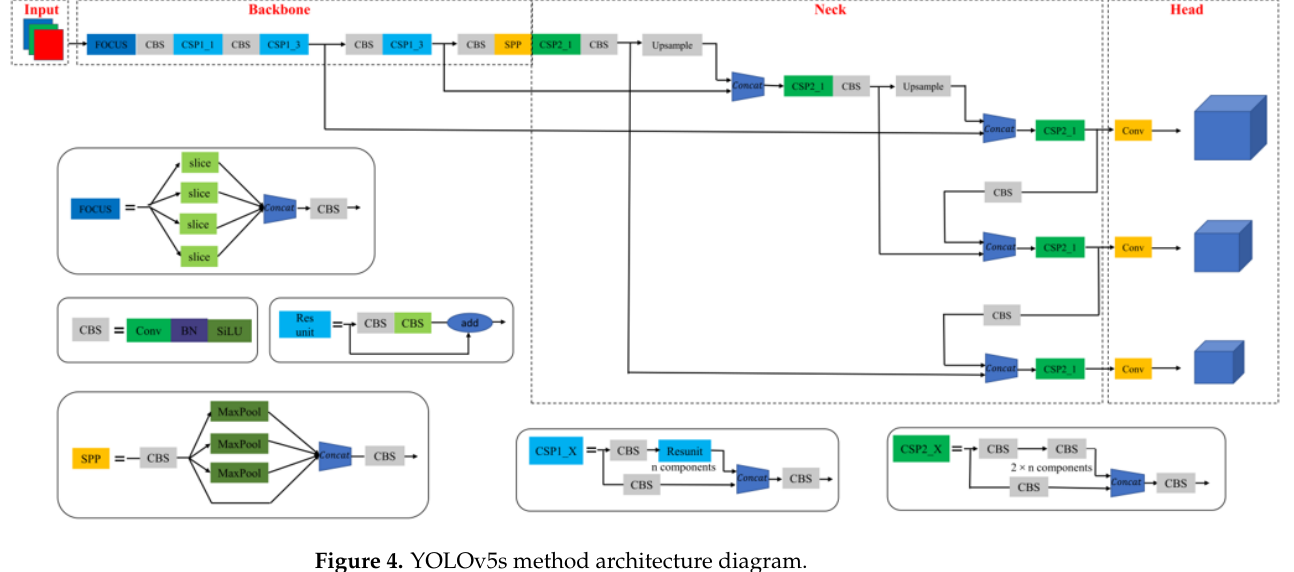
Figure 4. YOLOv5s method architecture diagram.